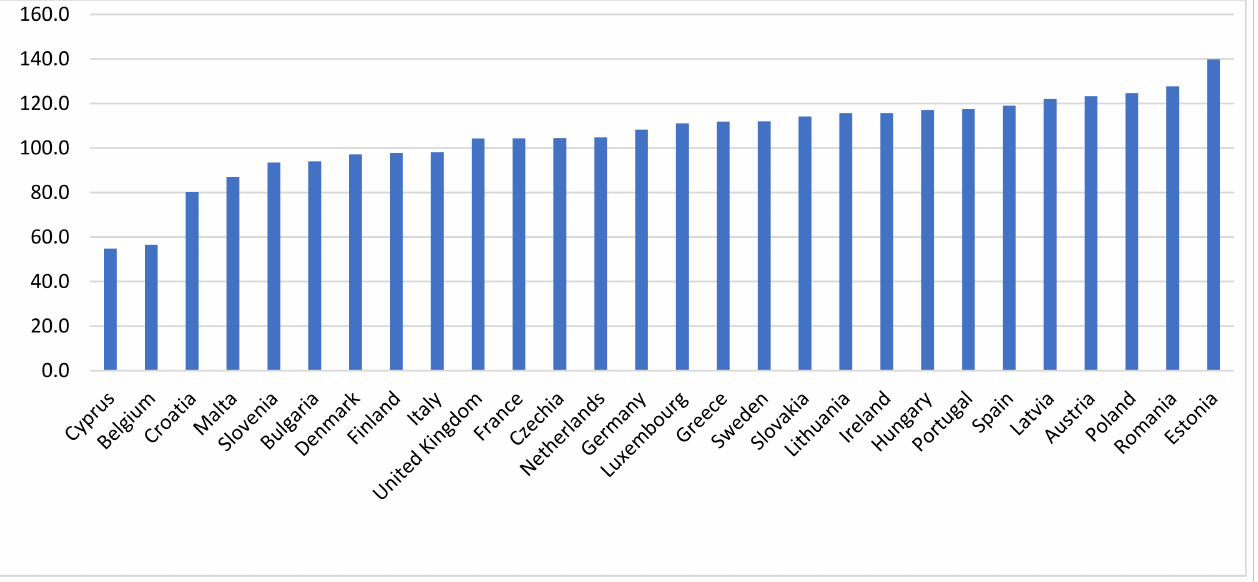
Figure 2. The dynamics of change in intermediate consumption per 1 ha of UAA from 2010 to 2019 (2010 =